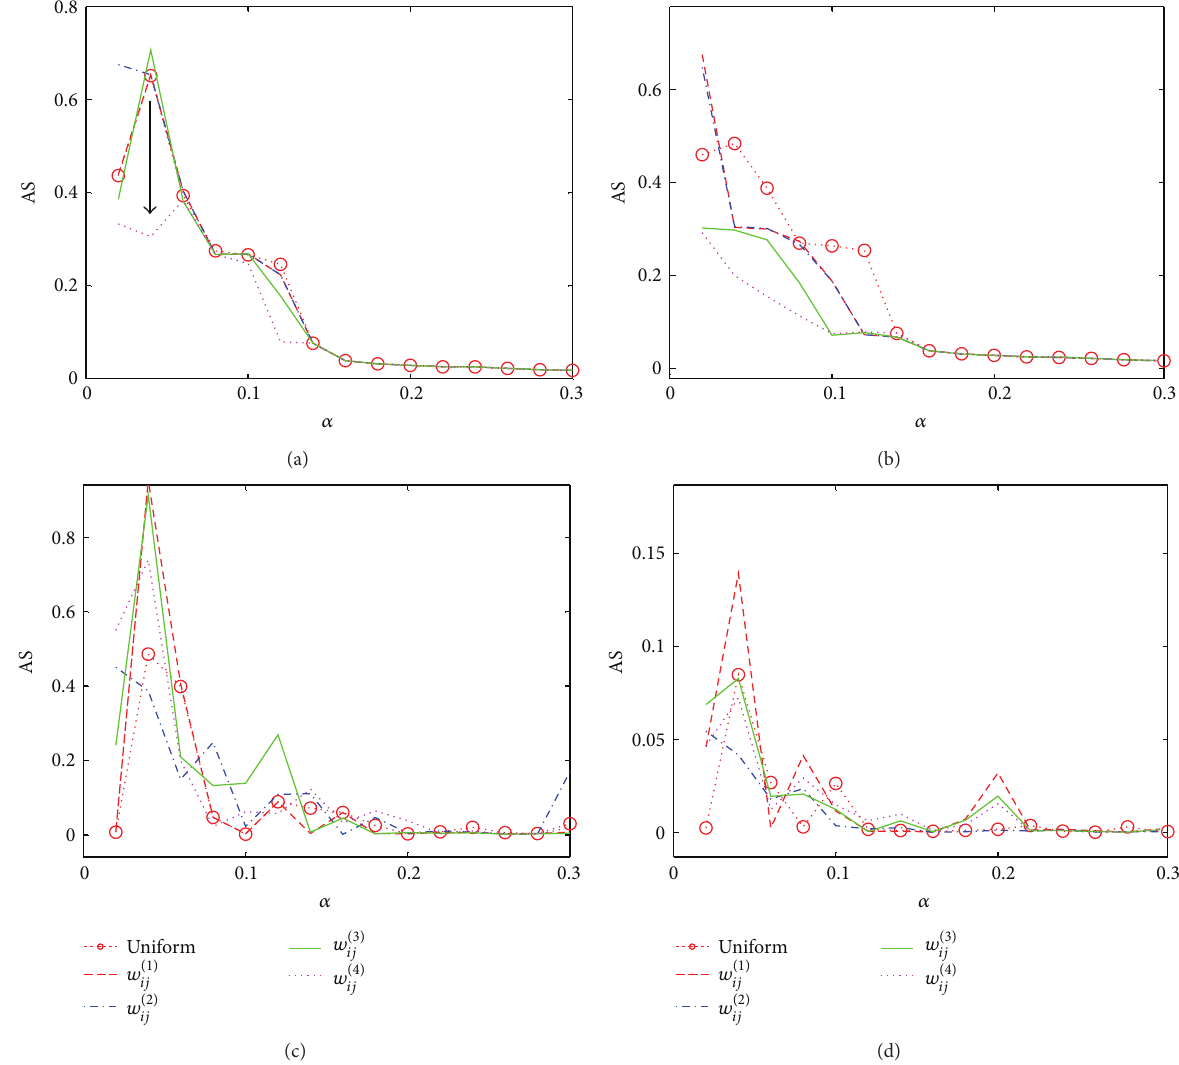
Figure 2: For SF network, after the cascade stops, the avalanche size AS as a function of 𝛼 for different strategies with (a) 𝜏 = 20 under HL attack, (b) 𝜏 = 100 under HL attack, (c) 𝜏 = 20 under RA attack, and (d) 𝜏 = 100 under RA attack, respectively. Here (c) and (d) are averaged over 20